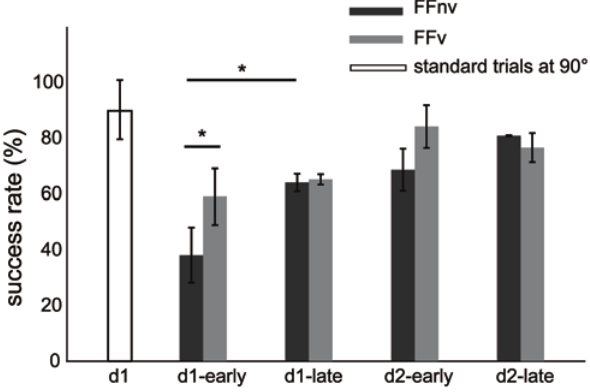
Figure 3. Success rates. Success rates in early and late adaptations to force fields with (FFv) and without visual feedback (FFnv) on day1 and day2. Success rate was calculated in 10 bins of 22 trials each. Each bar depicts the mean of the first or last 3 bins across all subjects in the group. The mean success rate for standard trials for the same direction (n=22) is also shown for FFnv. Vertical line is 6 1 standard deviation (*=p , 0.05).